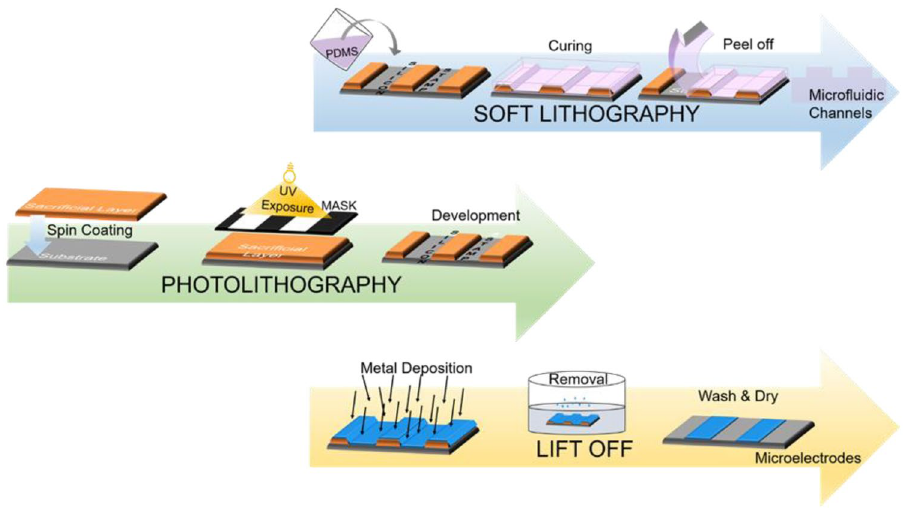
Figure 3. Illustration of three fabrication techniques for microelectrodes and microchannel development for the lab-on-a-film device. The photolithography process is used for the SU-8 created stamp on silicon substrate for microchannels fabrication. Soft lithography is adopted for the pattern transfer from silicon stamp into PDMS layer. And liftoff process is done for the microelectrode’s formation on a polypropylene film through a metal deposition.